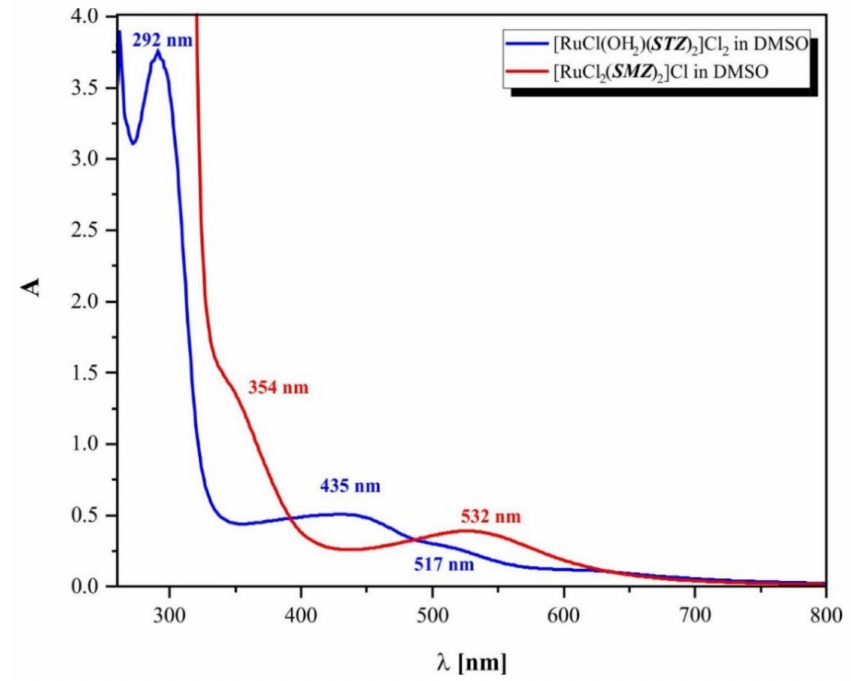
Figure 3. UV-Vis spectra of: (blue line) [RuCl(OH 2 )(STZ) 2 ]Cl 2 · H 2 O (1); (red line) [RuCl 2 (SMZ) 2 ]Cl (2) complexes’ solutions